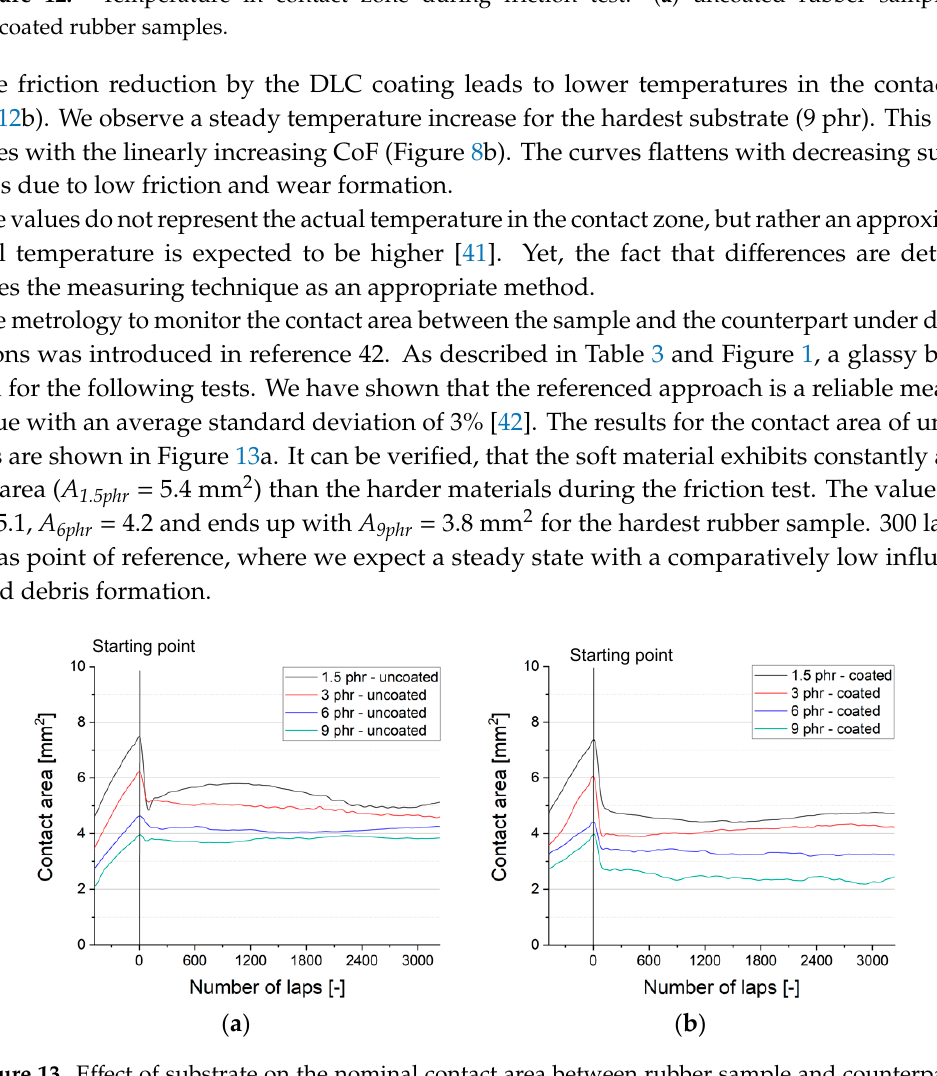
Figure 13. Effect of substrate on the nominal contact area between rubber sample and counterpart: ( a ) uncoated rubber samples; ( b ) coated rubber samples.